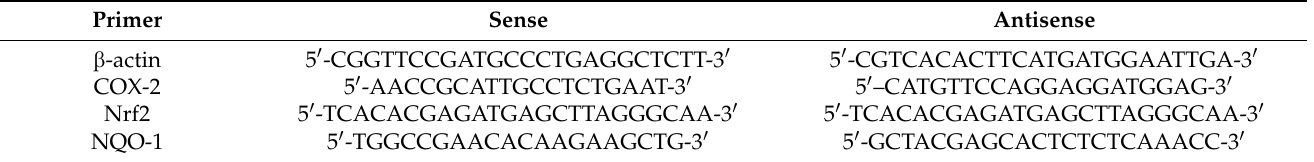
Table 1. Primers used to perform mRNA expression determinations by